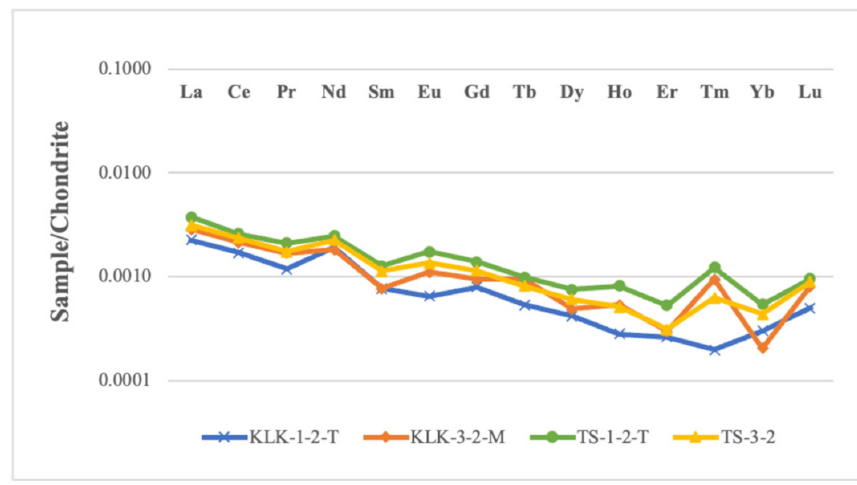
Figure 5. Chondrite-normalized REE patterns for different particles from Keluke Lake and Tuosu